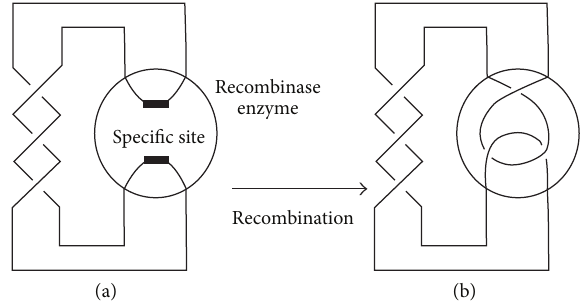
recombination. Site-specific recombination is a process